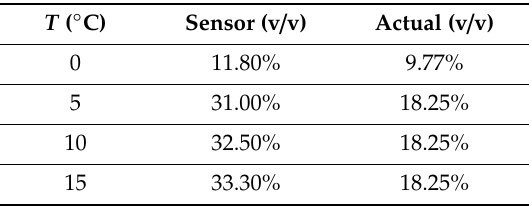
Table 3. Examples of sensor readings under various temperatures.